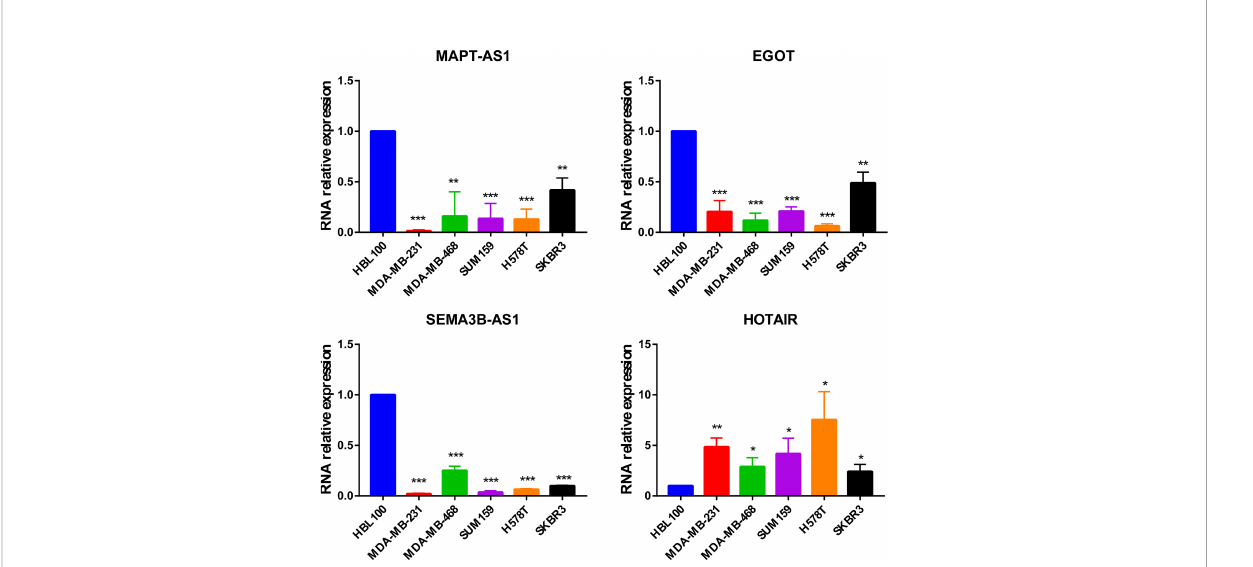
FIGURE 8 The expression of MAPT-AS1, EGOT, SEMA3B-AS1, and HOTAIR in human normal mammary epithelial cells and breast cancer cell lines. * p <0.05, ** p <0.01, *** p